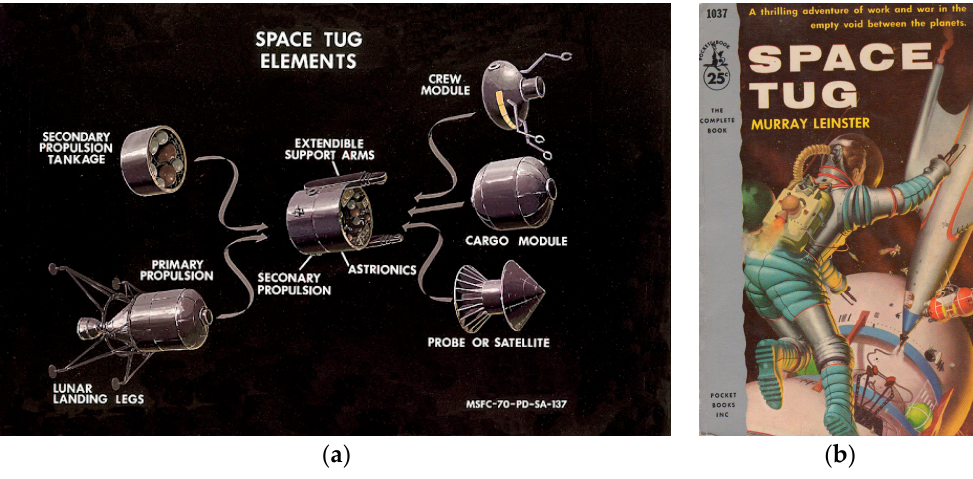
Figure 3. Two historical documents on “Space Tugs”: ( a ) a NASA drawing showing the various modules considered; ( b ) coverpage of one of the first documents (1953) citing and defining the “Space Tug” concept [7].